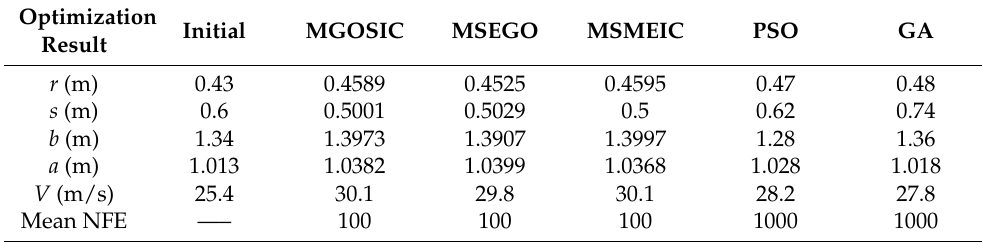
Table 9. The specific results of each